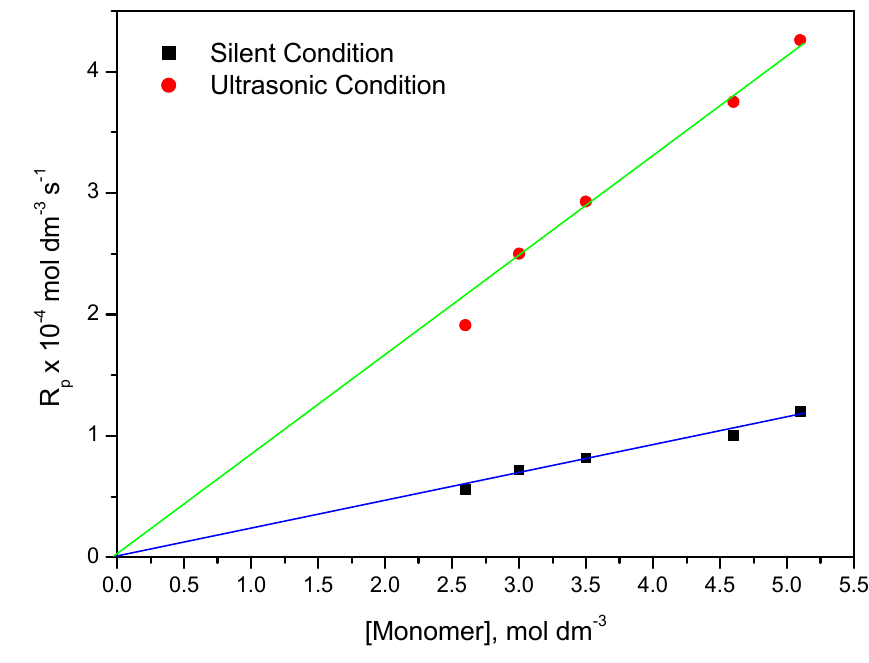
Figure 9. Influence of [MABE] on the rate of polymerization catalyzed by BPMACB: 2.00 × 10 − 2 mol·dm − 3 of PPS, 1.2 × 10 − 2 mol·dm − 3 of BPMACB, 0.3 mol·dm − 3 of [H +